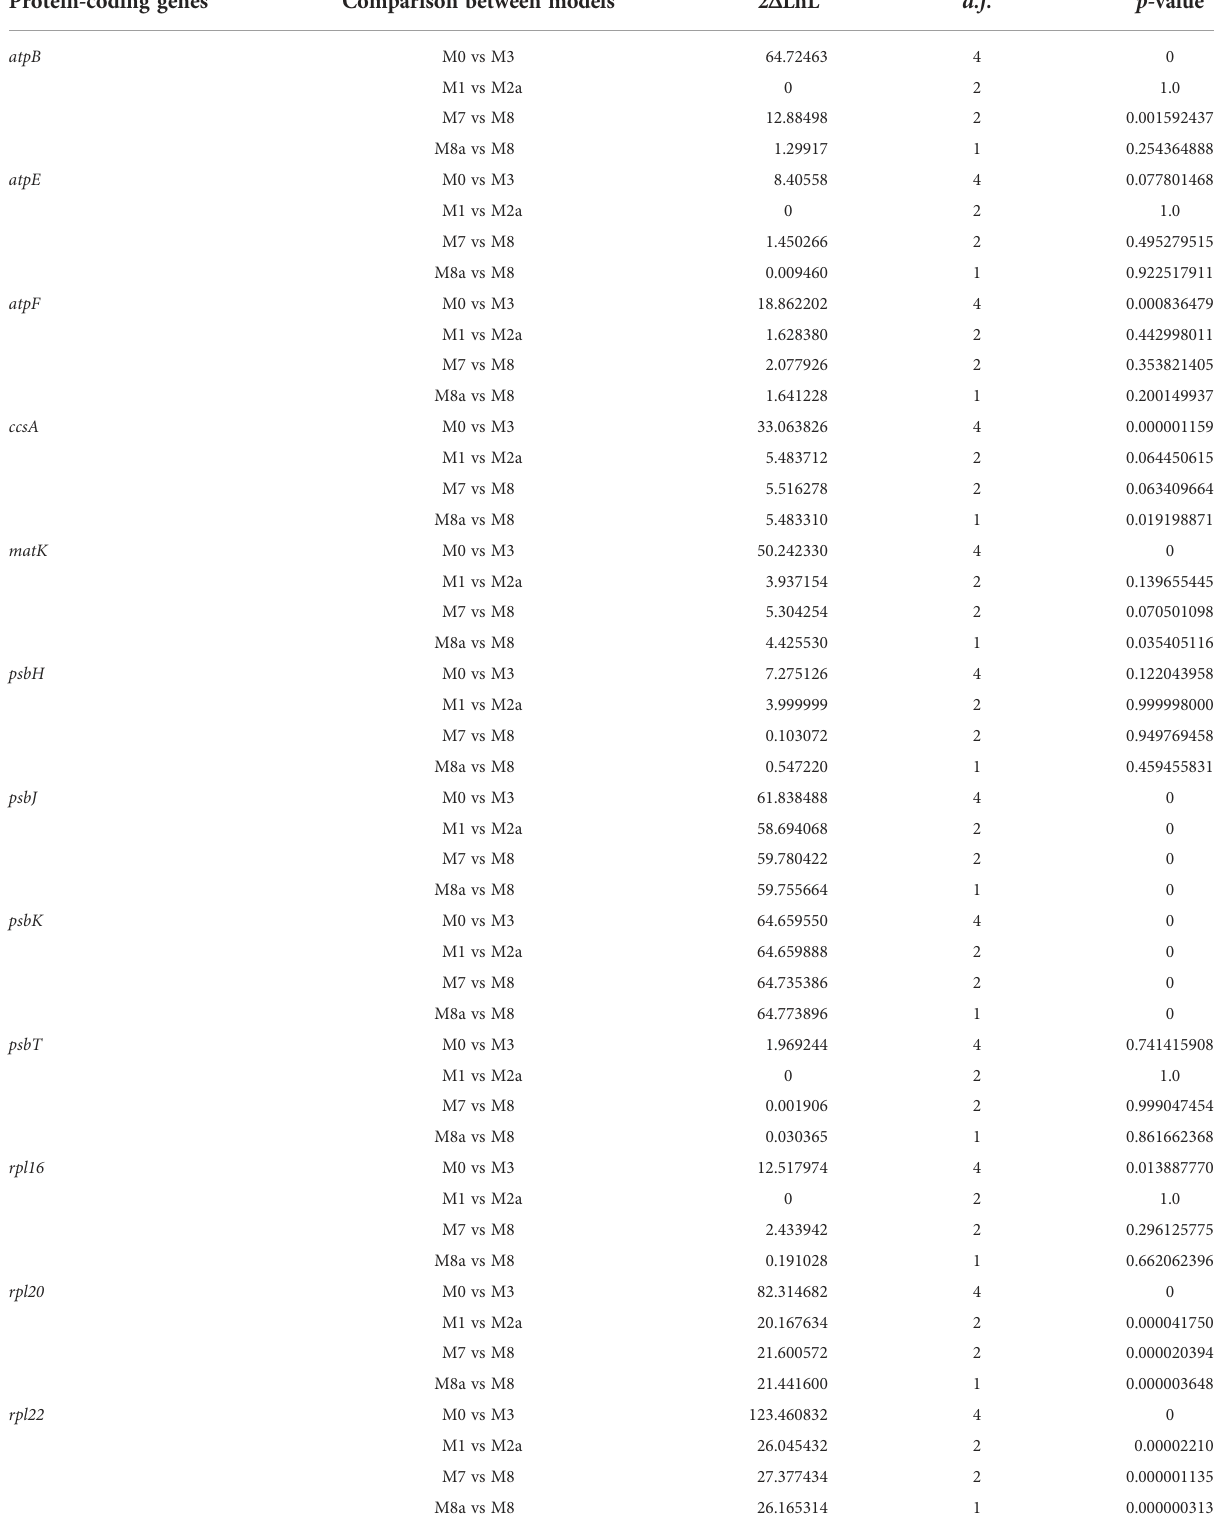
TABLE 2 Comparison of the likelihood ratio test (LRT) statistics of positive selection models against their null models (2 D LnL) for across all Corydalis species. Protein-coding